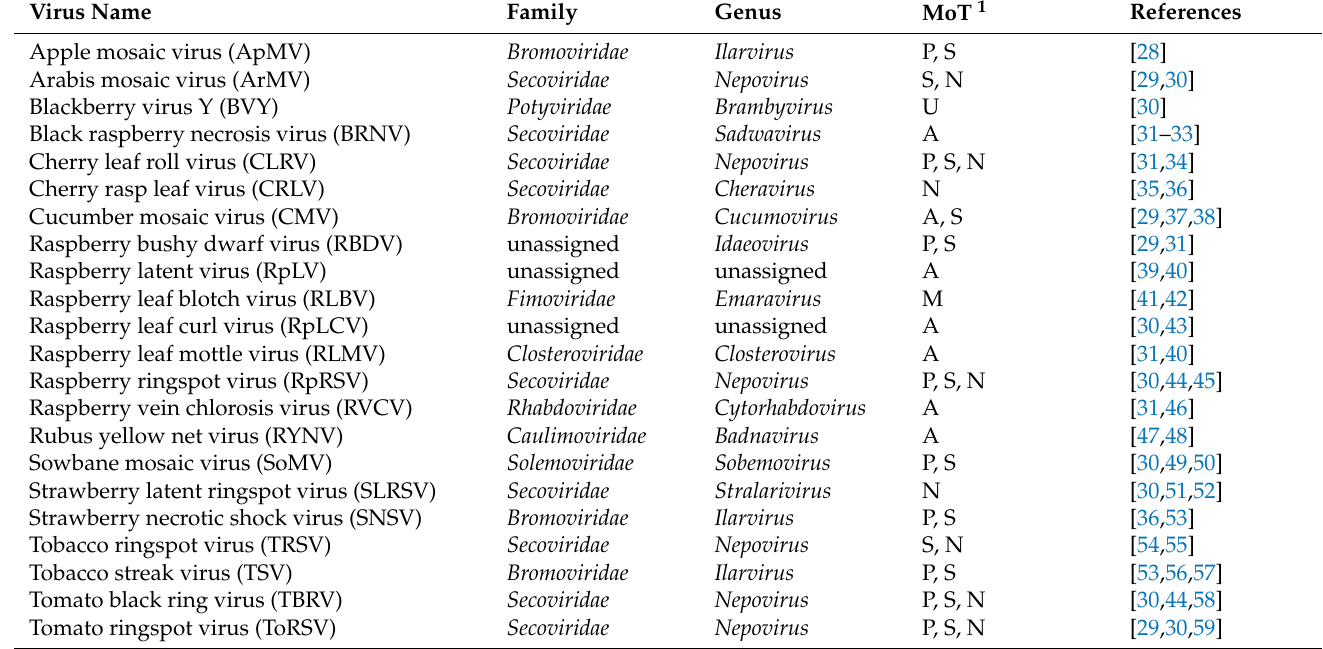
Table 1. The known raspberry ( Rubus idaeus ) viruses and their mode of transmission